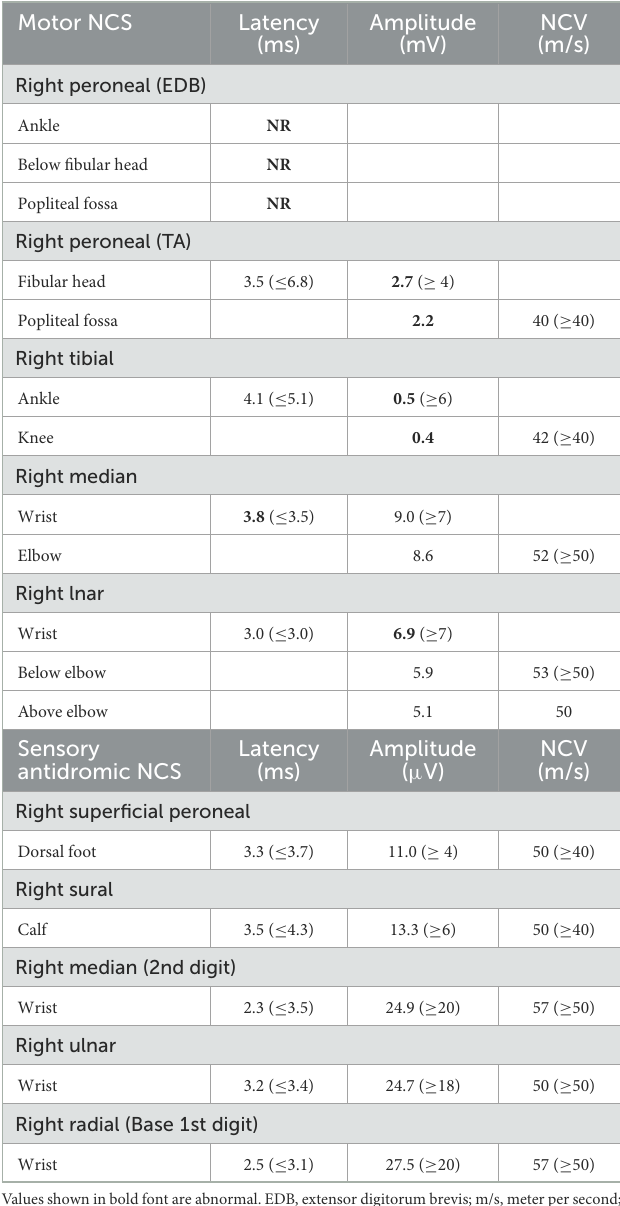
TABLE 1 Nerve conduction studies